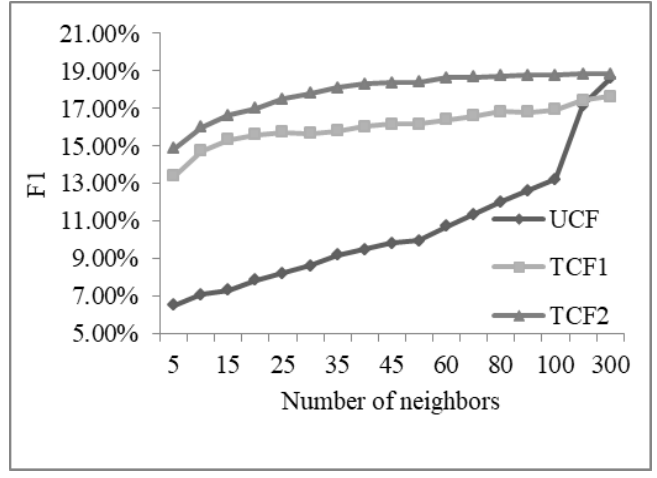
Figure 12. F1 with changing of the number of user neighbors.